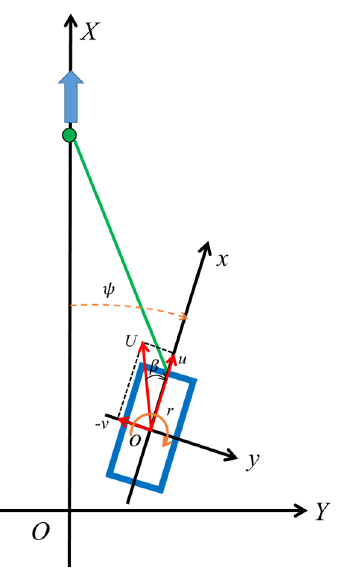
Figure 1. Coordinate system.